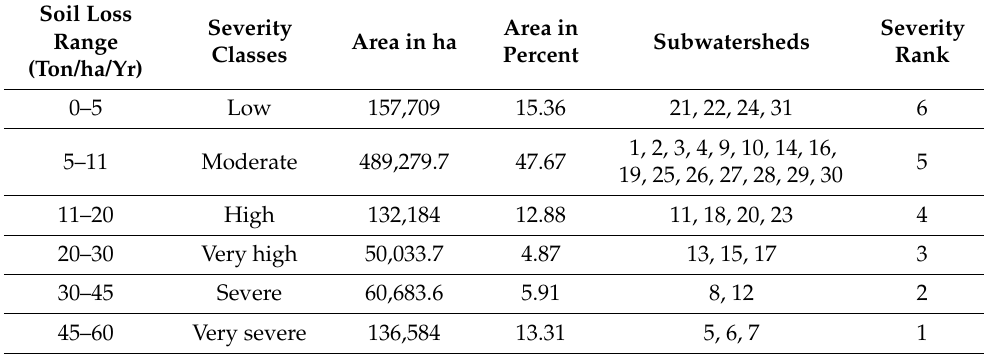
Table 10. Annual soil erosion and its severity classes of Genale Dawa-3 dam